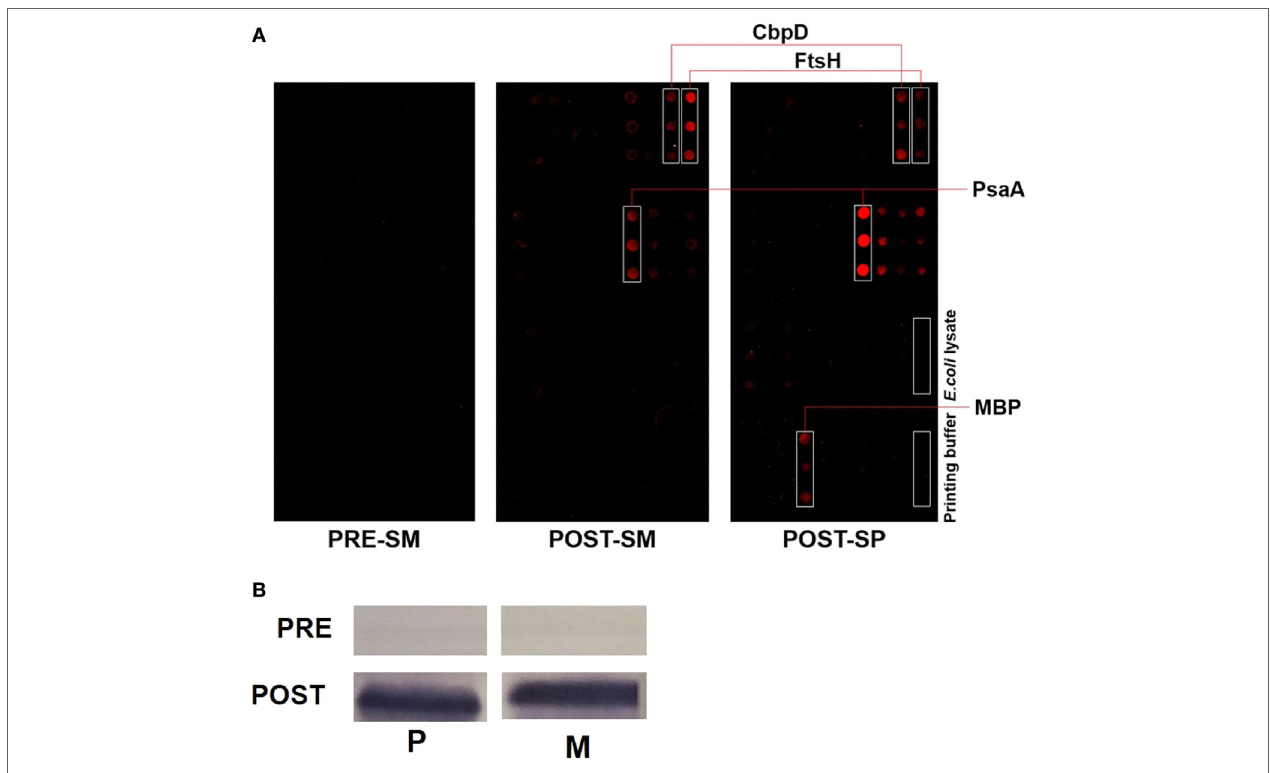
FigUre 6 | Identification of pneumococcal proteins that cross-react with rabbit Streptococcus mitis antisera. (a) Immunogenic screening of on-chip purified Streptococcus pneumoniae TIGR4 protein microarray. Lysates of 30 recombinant proteins overexpressed in E. coli were printed on the chelated Cu ++ /PEG surface slides in triplicates. The slides were probed with S. mitis and S. pneumoniae antiserum to identify immunoreactive pneumococcal antigens. Pre- and post-immune serum from rabbits challenged with S. mitis type strain, and post-immune serum from rabbits challenged with S. pneumoniae were used on the slides. Values were obtained by ratio of fluorescence intensity of spot to fluorescence intensity of E. coli cell lysate. E. coli , His-tag MBP; ~50% similarity to SP2108. Abbreviations: PRE-SM, pre-inoculation S. mitis serum; POST-SM, post-inoculation S. mitis serum; POST-SP, post-inoculation S. pneumoniae serum; CbpD, choline-binding protein D; FtsH, cell division protein; PsaA, manganese ABC transporter adhesion lipoprotein; MBP, maltose-binding protein. (B) Reactivity of rabbit anti- S. mitis IgG antisera with S. pneumoniae TIGR4 and S. mitis PsaA by SDS-PAGE in gradient gels and immunoblotting. Each lane was loaded with 50 µg of protein from the indicated bacterial species. The pre- and post-inoculation sera were diluted 1:1,000. Abbreviations: M, S. mitis CCUG31611; P, S. pneumoniae